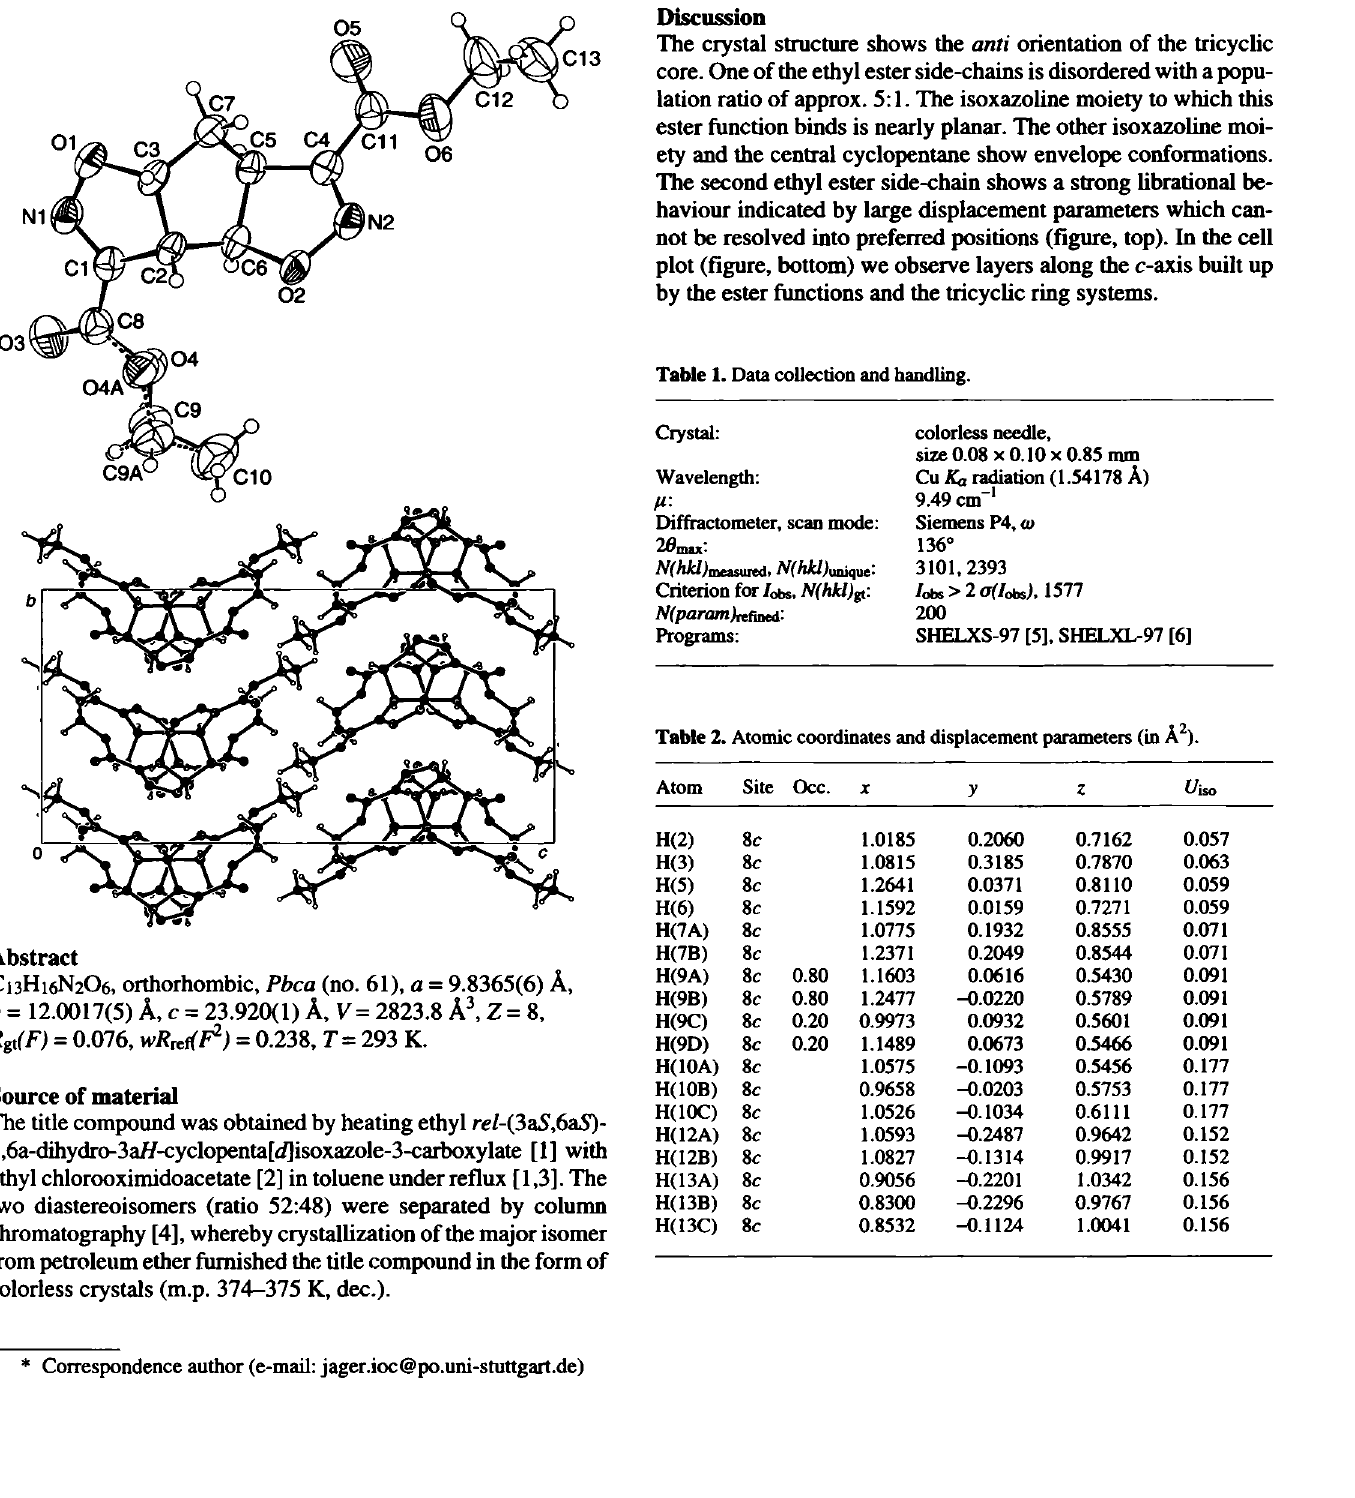
Table 2. Atomic coordinates and displacement parameters (in A ).